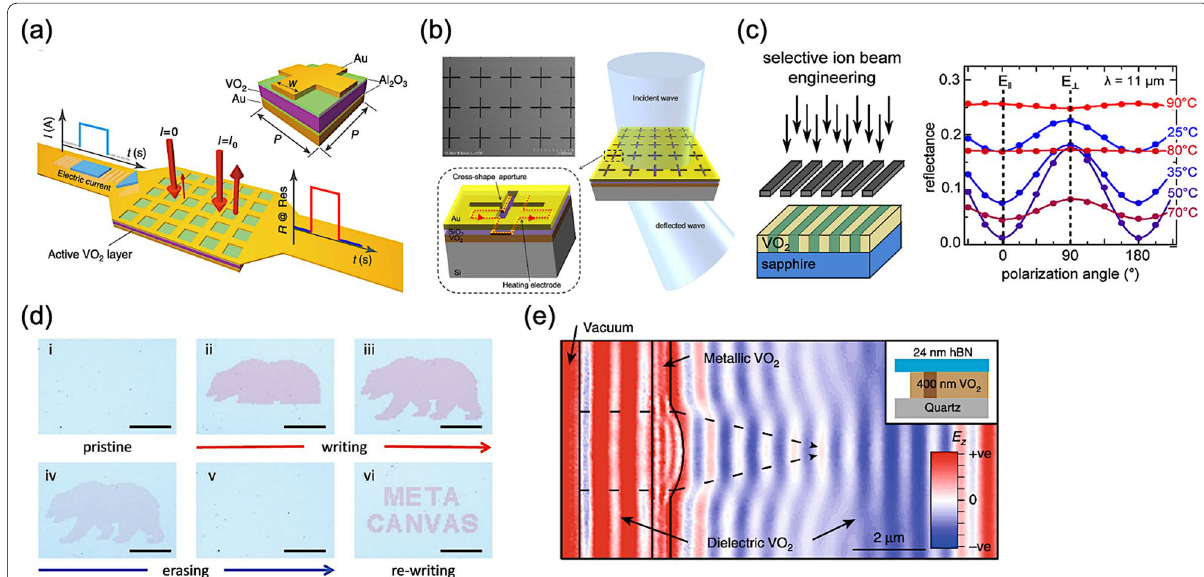
Fig. 3 Thermally reconfigurable and tunable metasurfaces with VO 2 a Meta‑device consisting of an insulator‑to‑metal transition material [65], b Beam‑steering metasurface with current‑induced heating electrode [66], c Metasurface based on selective defect engineering of phase transition material [67], d Relevant writing and erasing process on a rewritable metacanvas [68], and e Simulation of a refractive polariton lens with phase‑change material